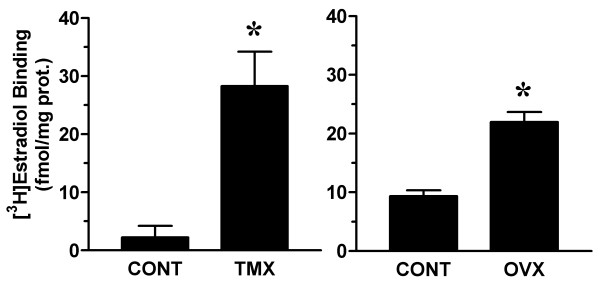
Effect of tamoxifen on vaginal estradiol receptor concentration. Total estradiol receptor concentration was determined by radioligand binding assay in vaginal tissue extracts from control (CONT) and tamoxifen-infused (TMX) rats (see Figure 1). For relative comparison, estradiol binding in vaginal tissue extracts from control and ovariectomized (OVX) rats was determined in separate assays. Data are the mean ± SEM from 3 independent assays. *p < 0.05 versus control group.